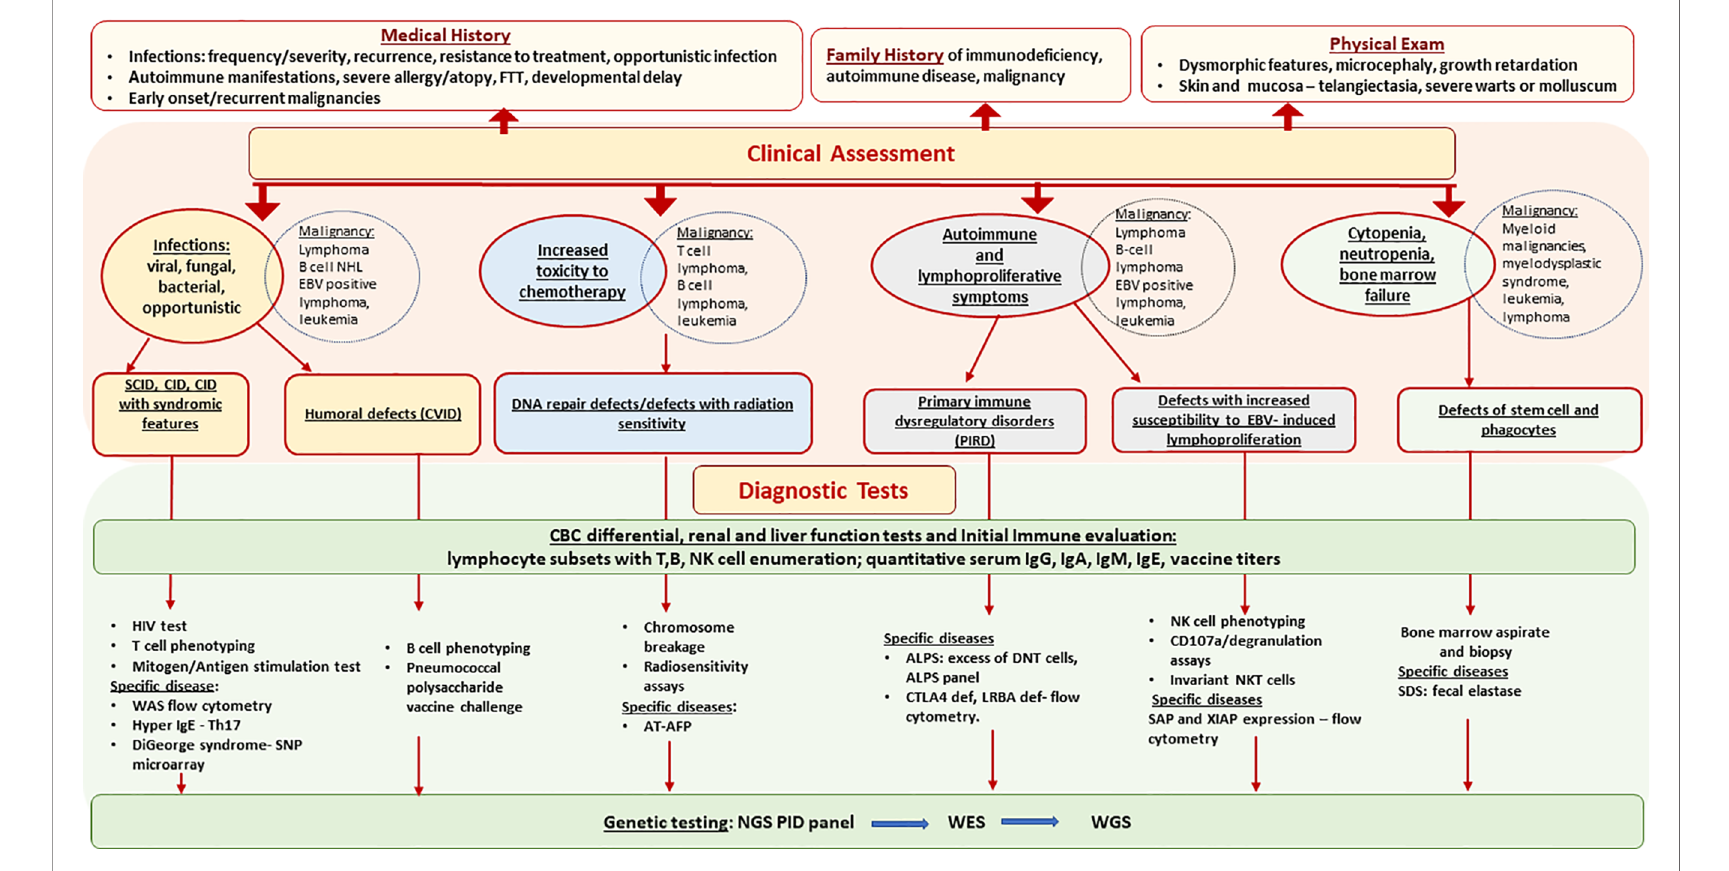
FIGURE 1 | Primary Immunode fi ciencies Associated with Hematologic Malignancy - Diagnostic Approach. AFP, alpha fetoprotein; ALPS, autoimmune lymphoproliferative syndrome; AT, ataxia telangiectasia; CID, combine immune de fi ciency; CVID, common variable immune de fi ciency; DNT, double negative cells, EBV, Epstein-Barr virus; FTT, failure to thrive; NGS, next generation sequencing; NHL, non Hodgkin ’ s lymphoma; SCID, severe combine immune de fi ciency; SDS, Schwachman Diamond syndrome; WAS, Wiskott Aldrich syndrome; WES, whole exome sequencing; WGS, whole genome